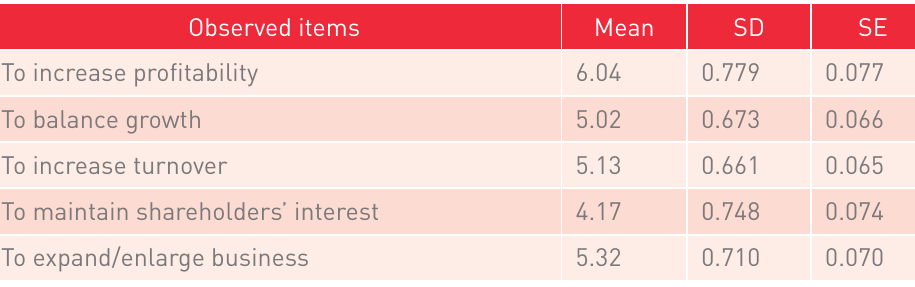
Descriptive analysis of the observed